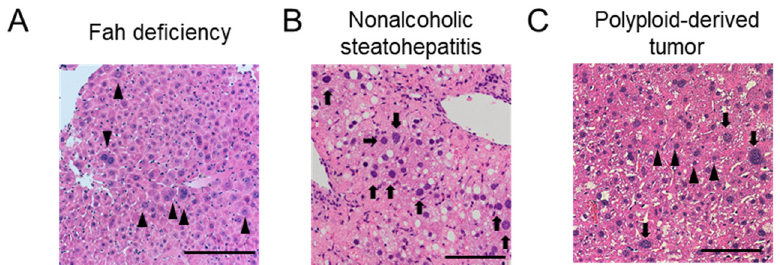
Figure 3. Ploidy alterations in mouse livers with various liver diseases. Representative hematoxylin and eosin staining images are shown. ( A ) Fah deficiency, a model of familial tyrosinemia [37]. Some mononucleated and binucleated polyploid hepatocytes are indicated by arrow heads. ( B ) Nonalco- holic steatohepatitis [46]. Some polyploid hepatocytes with a large nucleus are indicated by arrows. ( C ) Tumor derived from polyploid hepatocytes [46]. Please note that cancer cells derived from polyploid hepatocytes frequently undergo ploidy reduction and that the tumor is composed of both cancer cells with a small nucleus (arrow heads) and those with a large nucleus (arrows). Scale bars, 100 μ m.